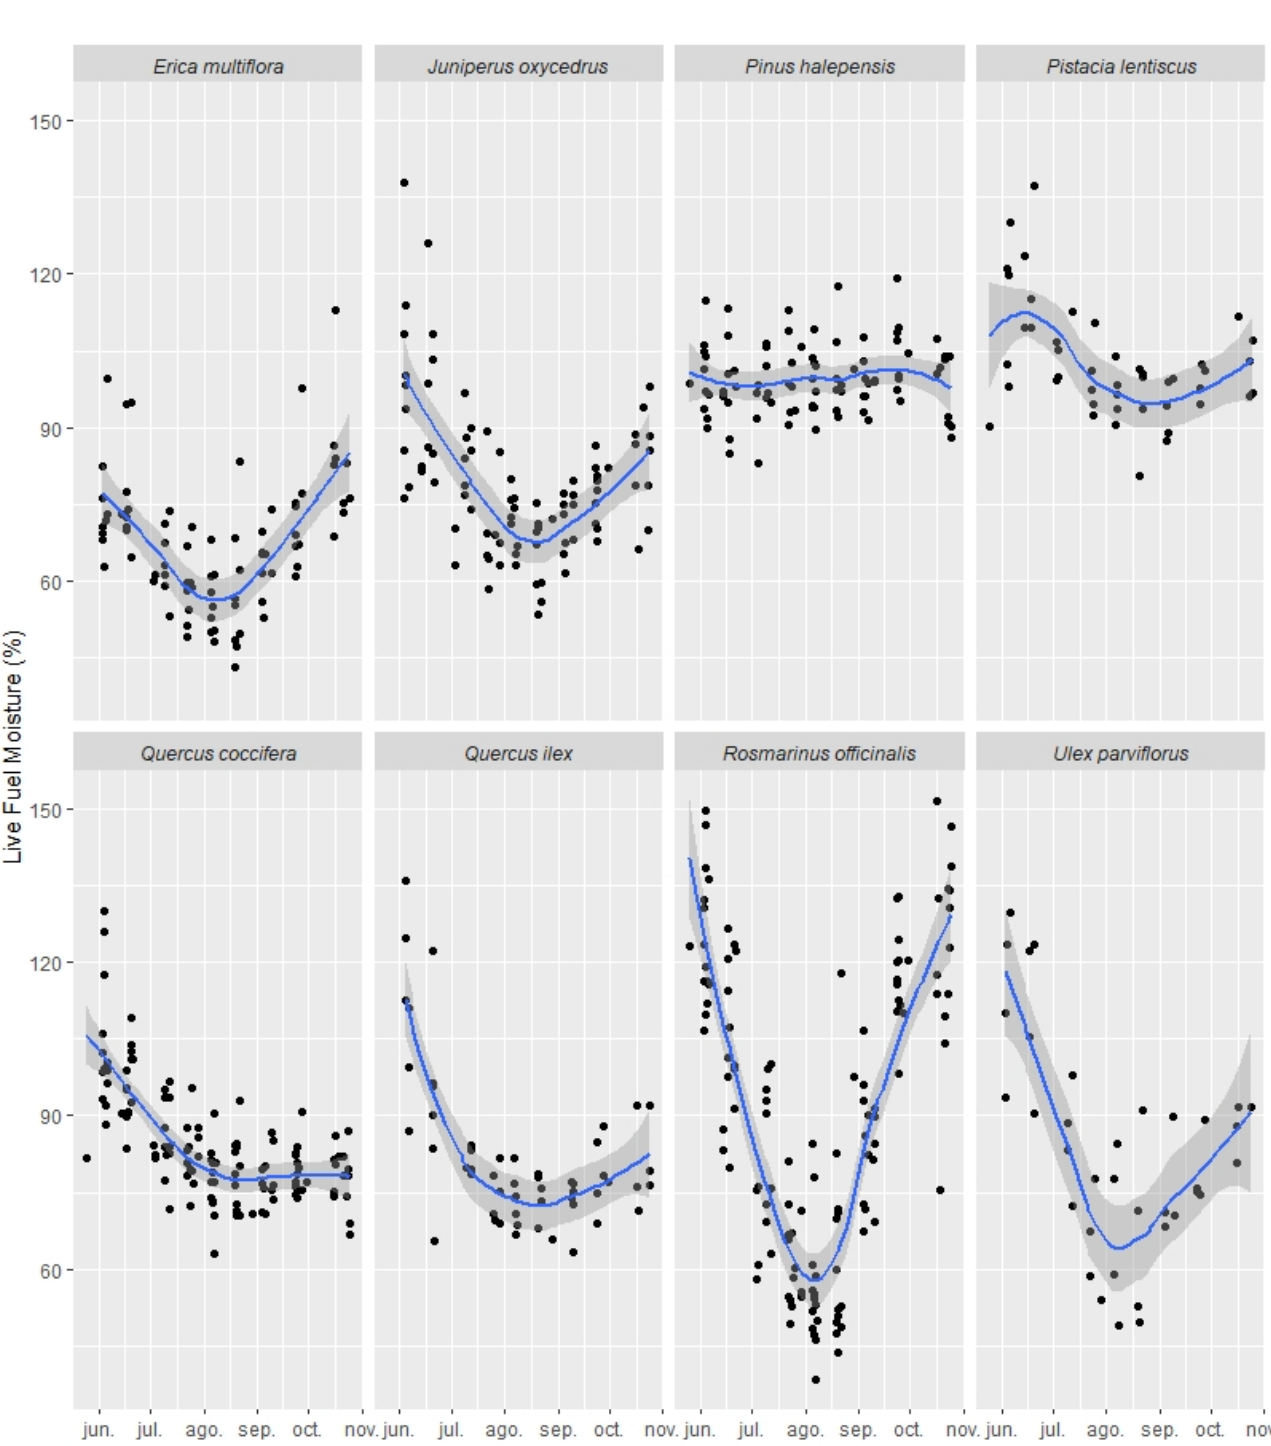
Figure 3. LFMC variation across species during the studied period (June–October 2019). Blue lines represent smoothed functions, black dots represent LFMC values at all sampling sites in the different collection dates, and grey shadows represent the 95% confidence interval level.